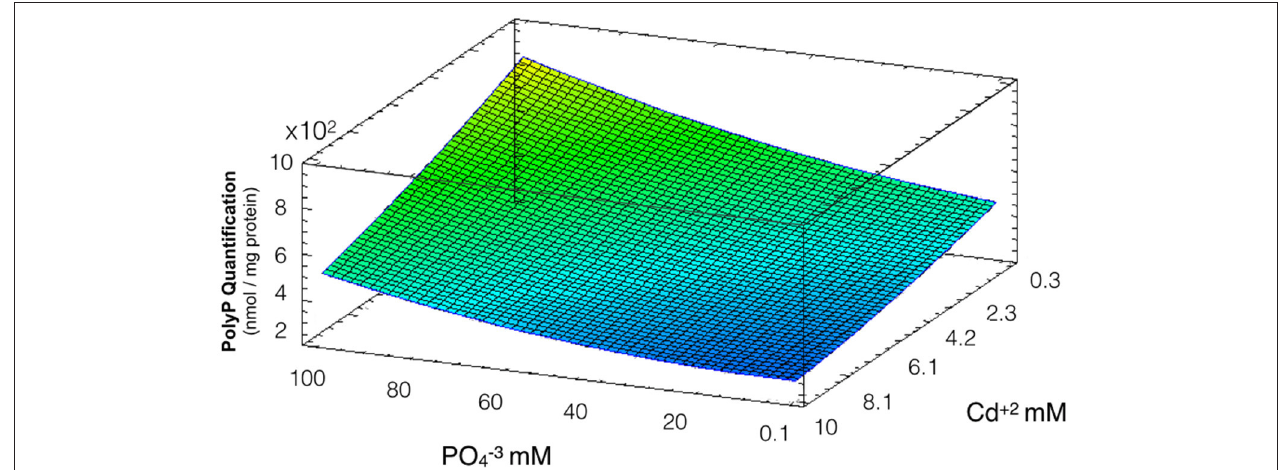
FIGURE 4 | Response surface for a two variables model describing the effect of cadmium and phosphate on polyP levels during QDs formation conditions ( R 2 : 86%, p < 0.05). All bacterial cultures display the same PolyP concentration in the absence of Cd and phosphate (they all become from the same stock), and the levels of PolyP were determined (nmol PolyP/mg protein) after 24h exposure to different concentrations of cadmium and